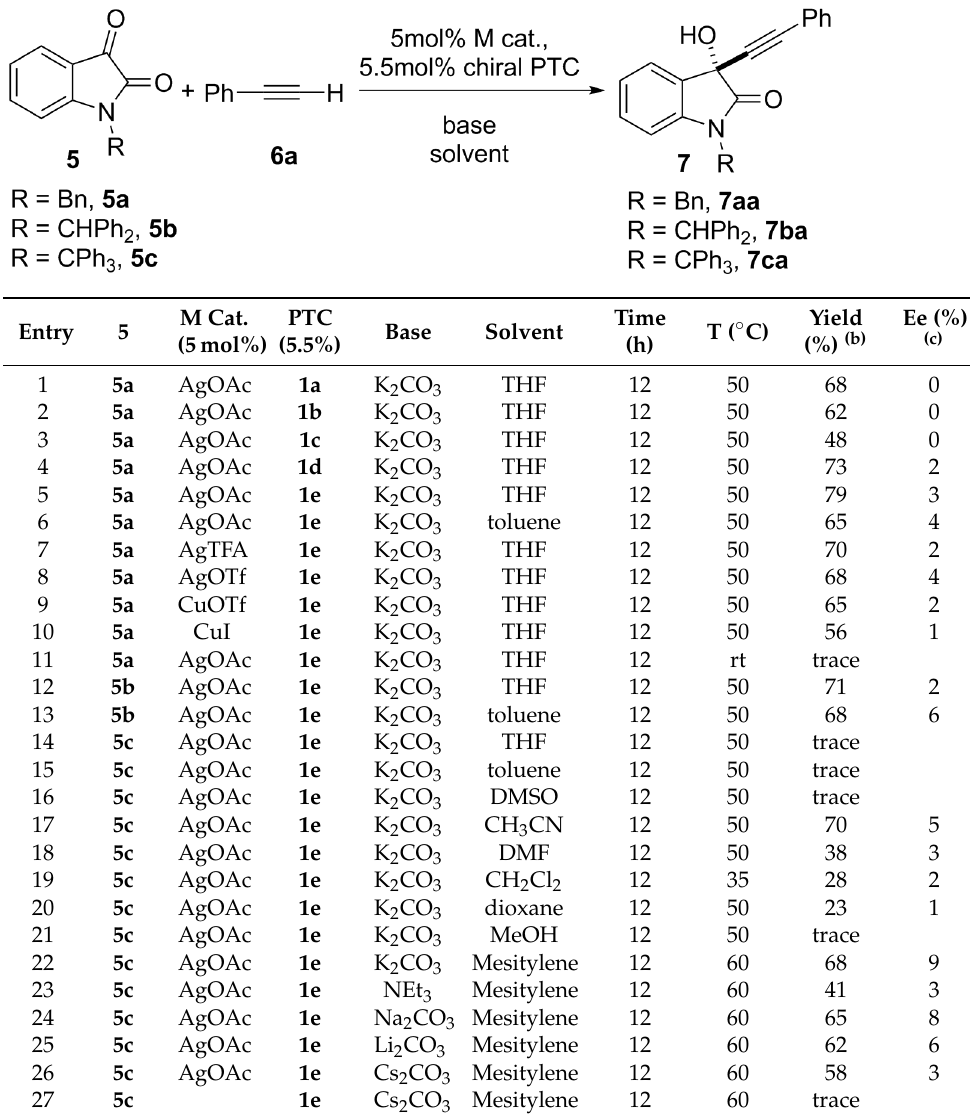
Table 1. Optimization of the reaction conditions (a) .